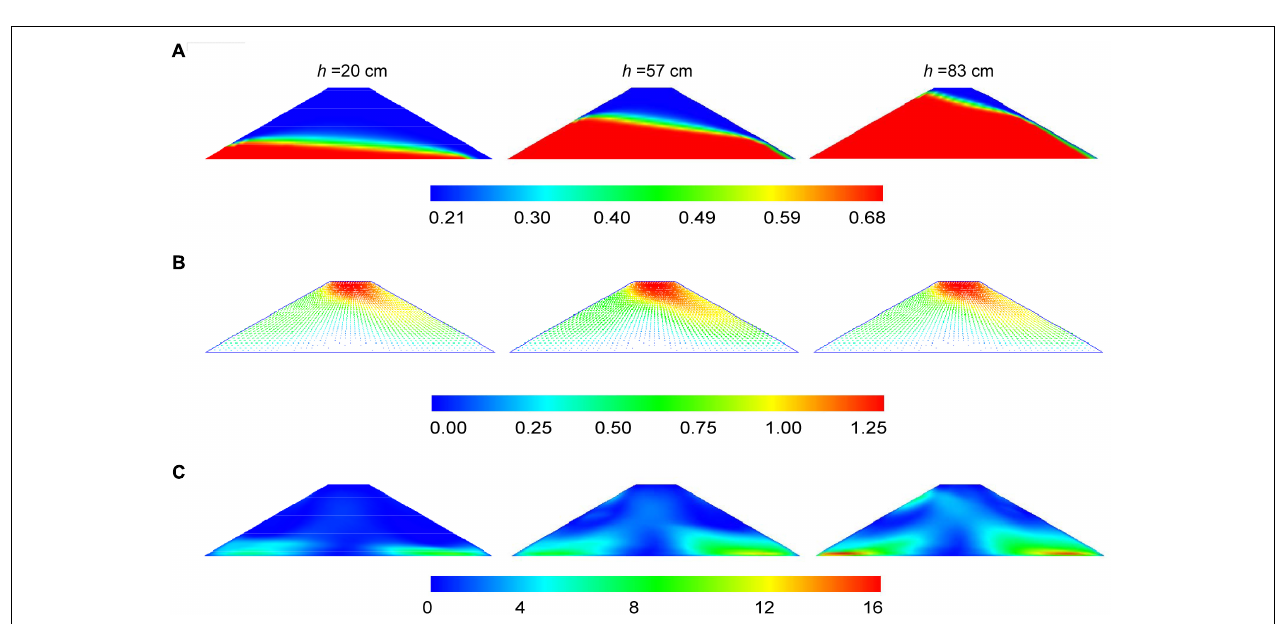
FIGURE 13 | Evolution of (A) saturation degree, (B) displacement field, and (C) shear strain during a seepage failure process (Xiong et al., 2018).